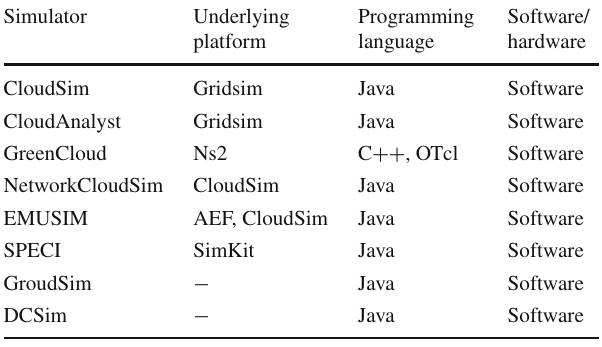
Table 2 Comparison of cloud computing simulators